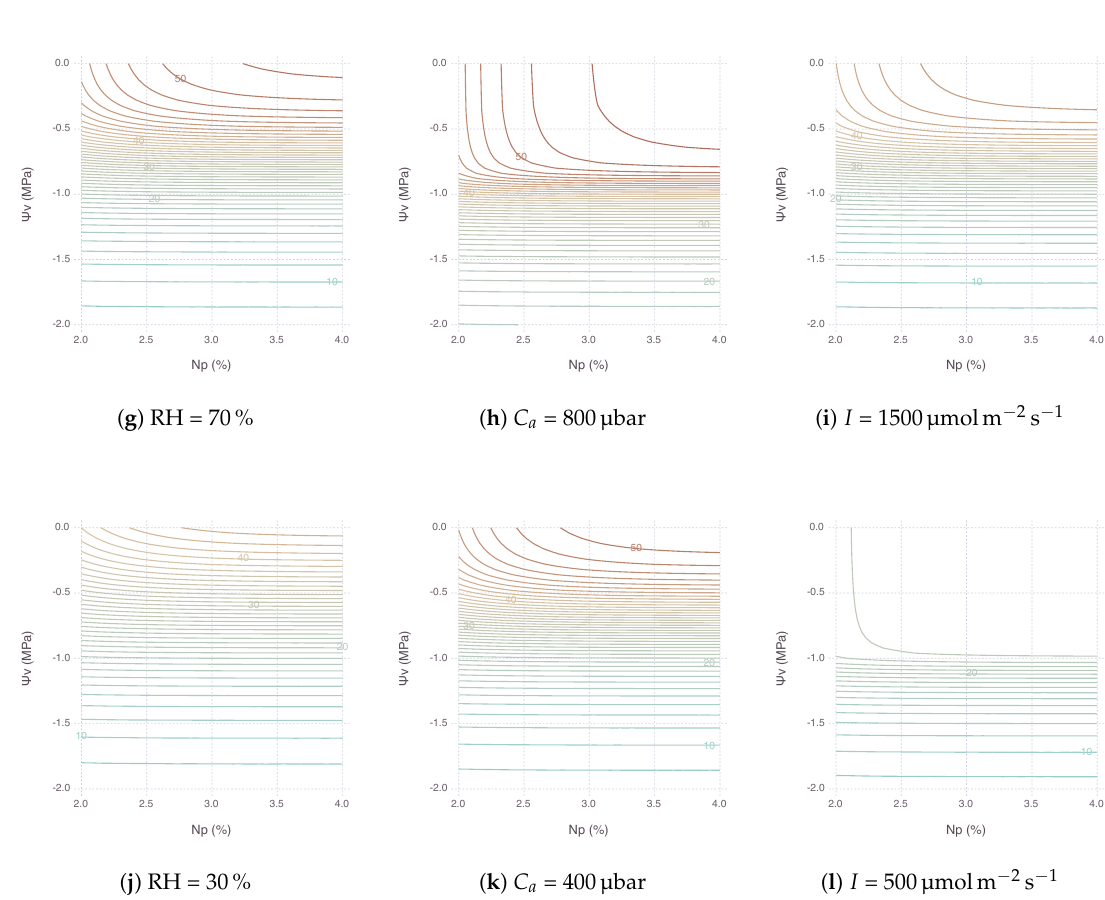
Figure 6. Responses of net photosynthesis rate ( A n ) under nitrogen and water stress implied by relative leaf nitrogen content ( N p ) and bulk leaf water potential ( Ψ v ) for the two variants of coupled gas-exchange model using Ball–Berry (BB) and Medlyn (MED). ( a , d , g , j ) Contrasting effects of high and low relative humidity. ( b , e , h , k ) Comparison between elevated and current concentrations of atmospheric CO 2 ( C a ). ( c , f , i , l ) Comparison between high and low levels of irradiance ( I ). Contour lines are spaced at an interval of 1µmolm − 2 s − 1 of the simulated A n